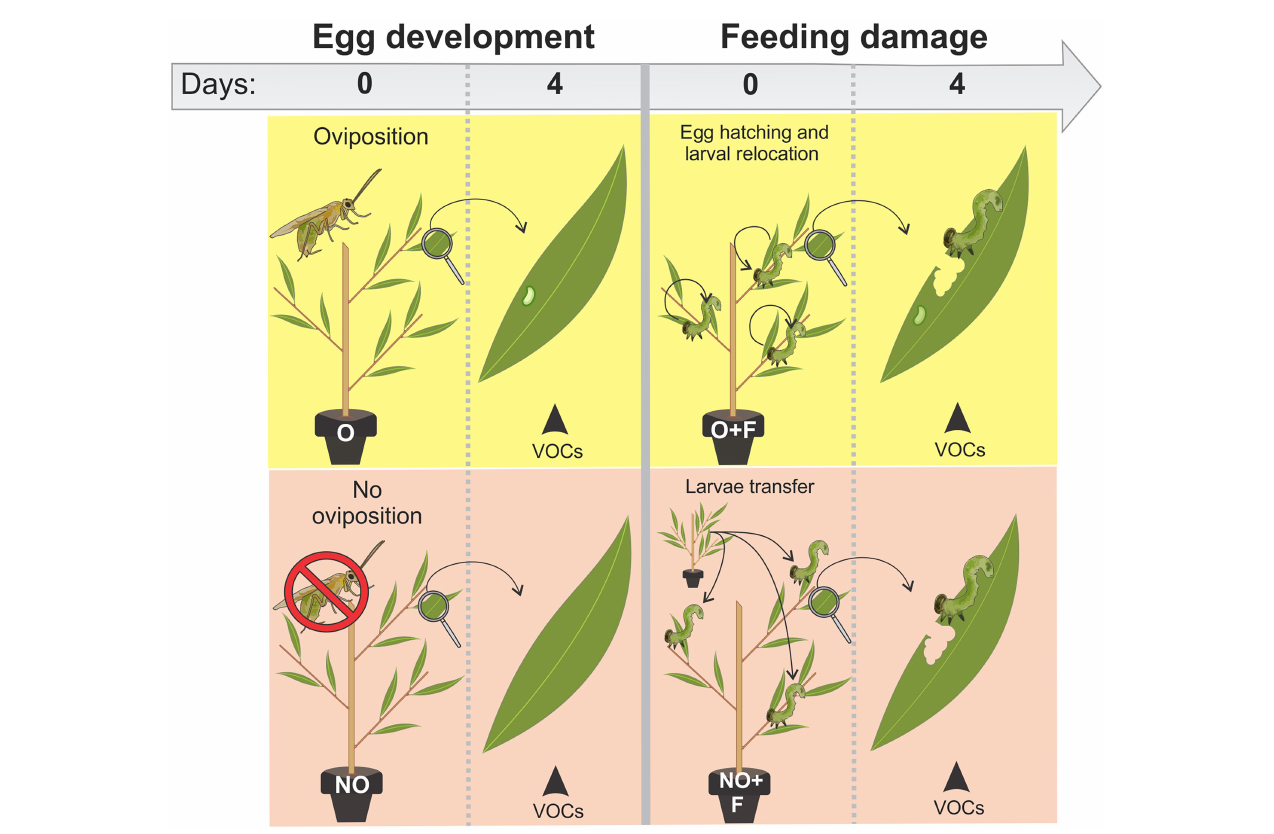
FIGURE 1 Experimental setup I scheme to evaluate insect performance and plant volatile emission. Plants were subjected to two sequential treatments: oviposition (4 days of egg development) and feeding damage (4 days of larval feeding). A first group of willows were subjected to prior oviposition (O). A second group was left without eggs (no oviposition treatment, NO). O and NO plants were subjected to feeding damage by neonates from their hatching day on (Day 0 of feeding damage). O + F plants were damaged with neonate larvae hatched from their own egg depositions. NO + F plants carried neonates transferred from oviposited non-experimental willows. VOCs arrows indicate the time when volatiles emission was measured.